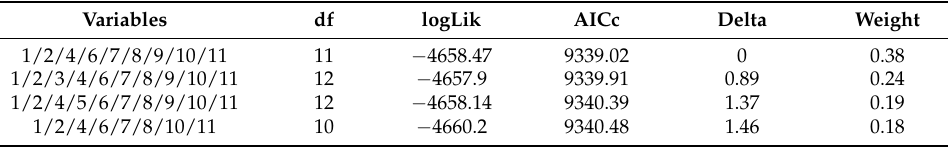
Table A3. Summary table of component models from model